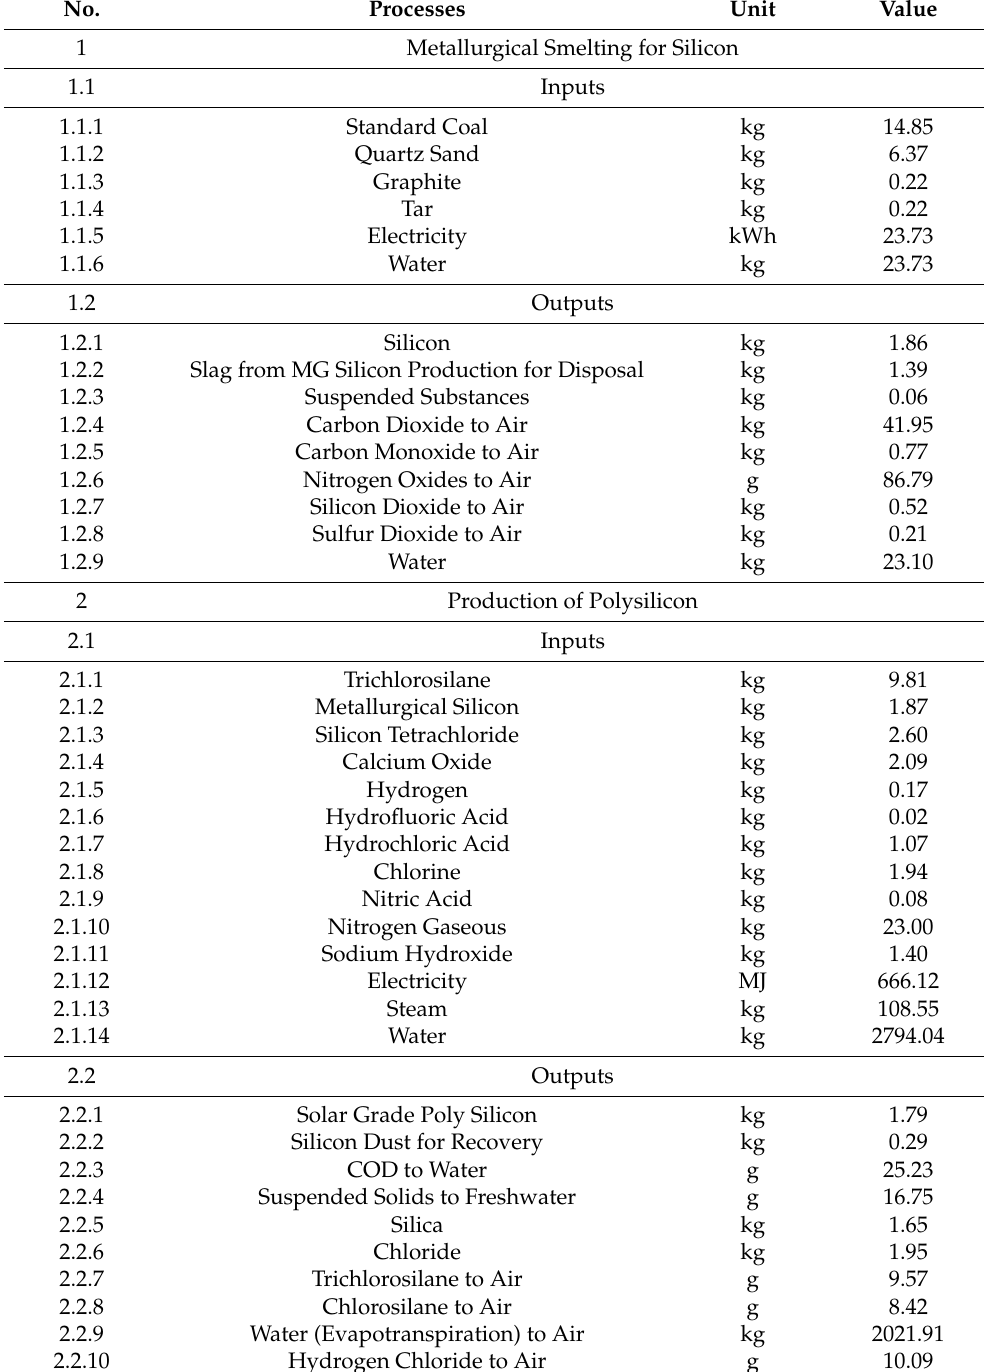
Table A1. Flows for the production processes of the selected 330 Wp polycrystalline PV